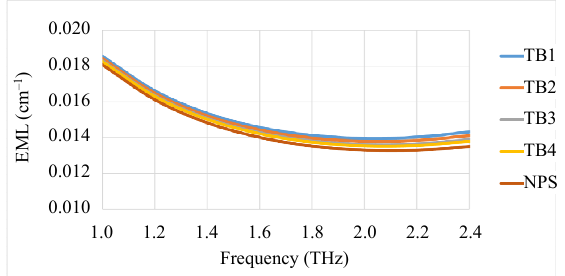
Fig. 4 EML of the proposed sensor for various samples infected with tuberculosis versus frequency.